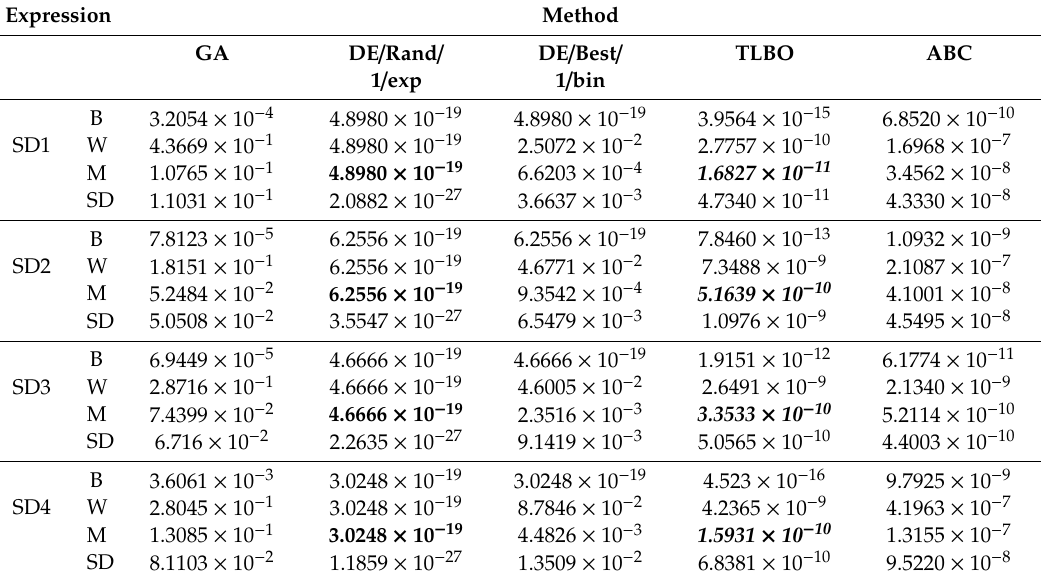
Table 5. OF B, W, M value, and SD for 50 independent runs of di ff erent methods.